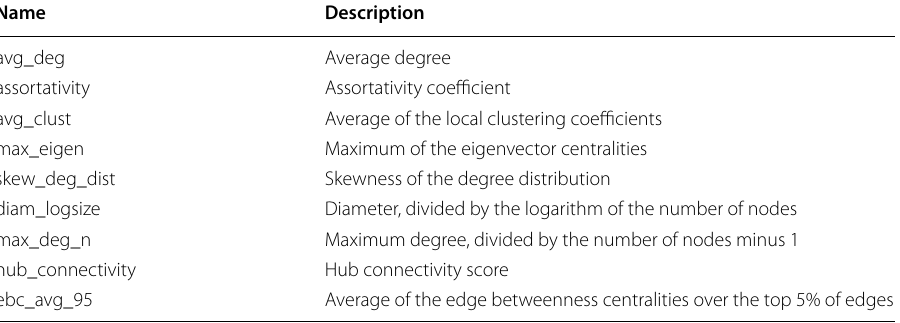
Table 5 Name and description of the chosen explanatory variables, for the classification